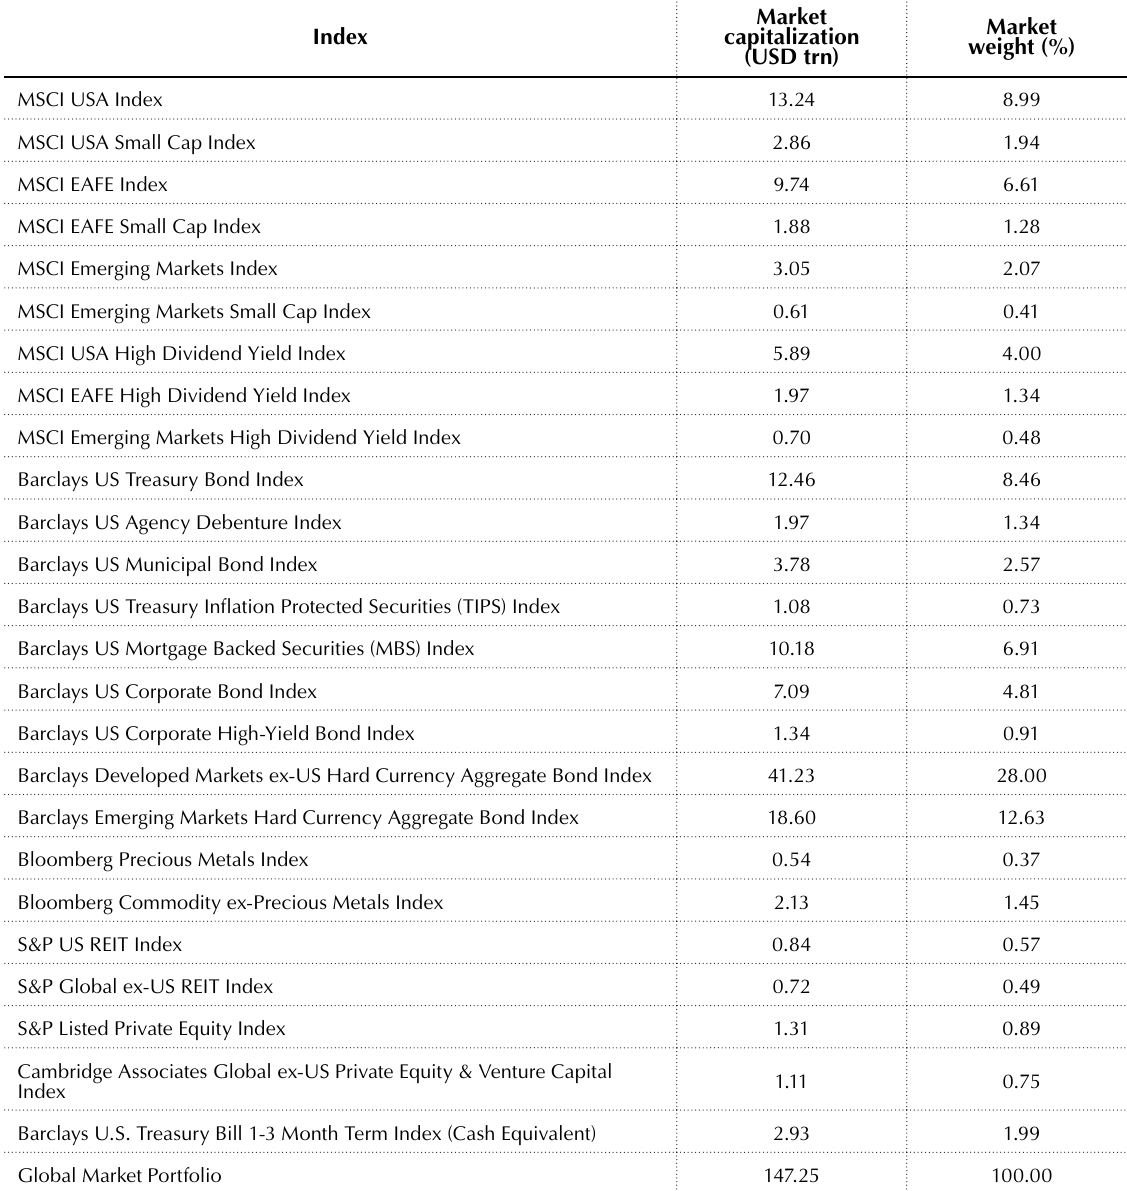
Market Market capitalization weight (%) (USD trn)